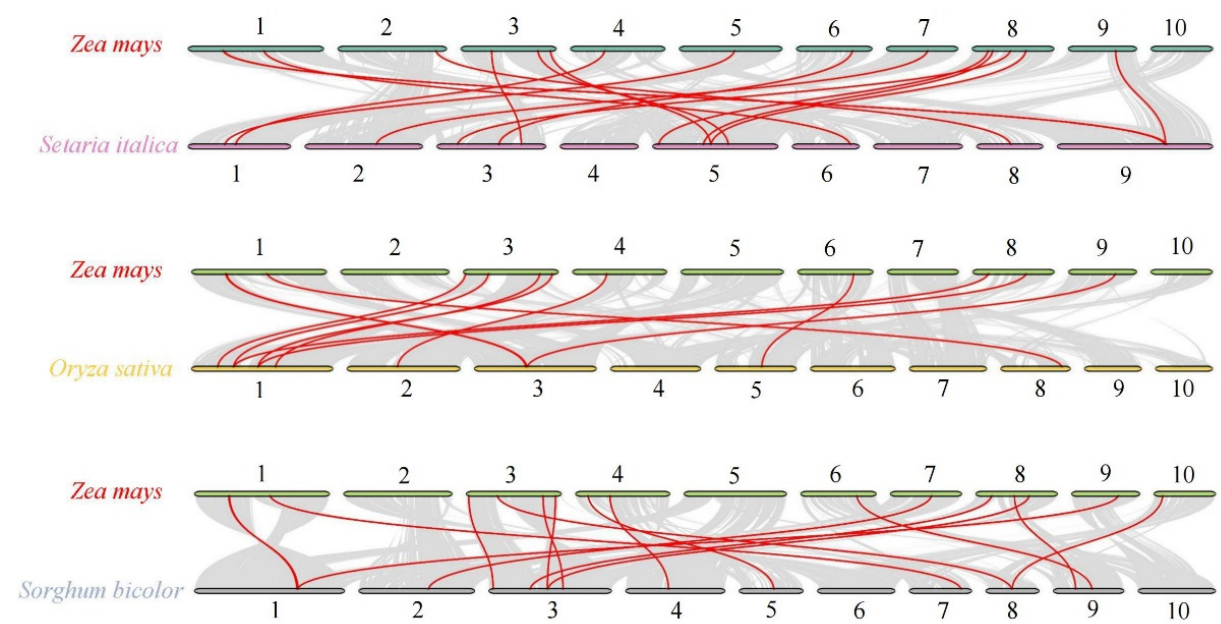
Figure 4. Synteny analysis of SWEET genes between maize and three representative graminaceous species. Gray lines in the background show collinear blocks in the genomes of maize and foxtail millet, rice, and sorghum, and red lines highlight the collinear SWEET gene pairs.